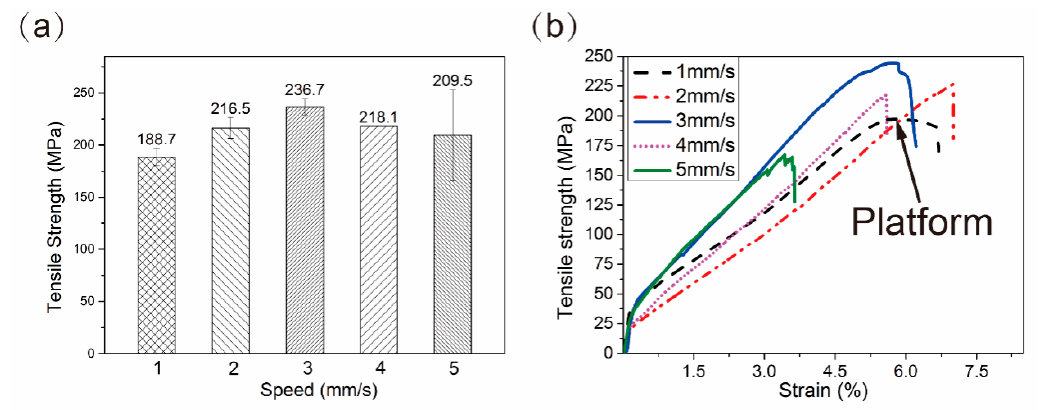
Figure 2. ( a ) Tensile strengths of CF / PbSn composites specimen S1, S2, S3, S4 and S5; ( b ) Typical strength is seen in strain curve of the printed CF / PbSn composites.